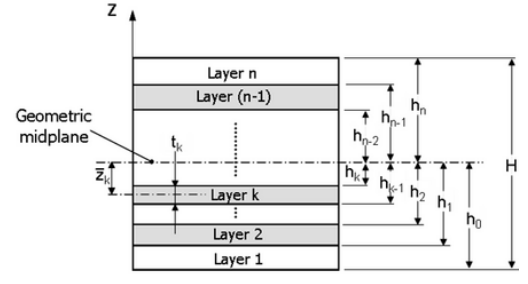
Figure 11. The scheme of the laminate notation This approach leads to the formation of the known ABD matrix, which relates forces and moments (per unit with) to the laminate midplane curvatures and strains. ABD matrix is a function of lamina thicknesses, lamina phases (fibers and matrix) characteristics, and mutual phases volume fraction ratios. and moments related to midplane curvatures